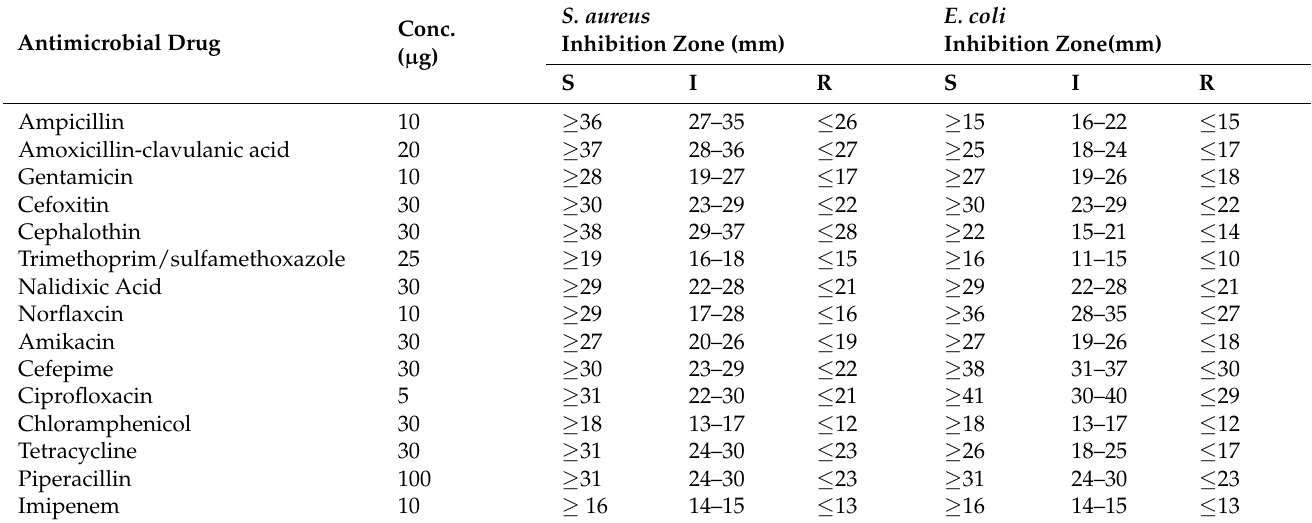
Table 1. Zone Diameter Interpretative references (NCCLS *) for various antimicrobials against Staphylococcus aureus and Escherichia coli strains isolated from chilled ground meat samples. Conc. Antimicrobial Drug